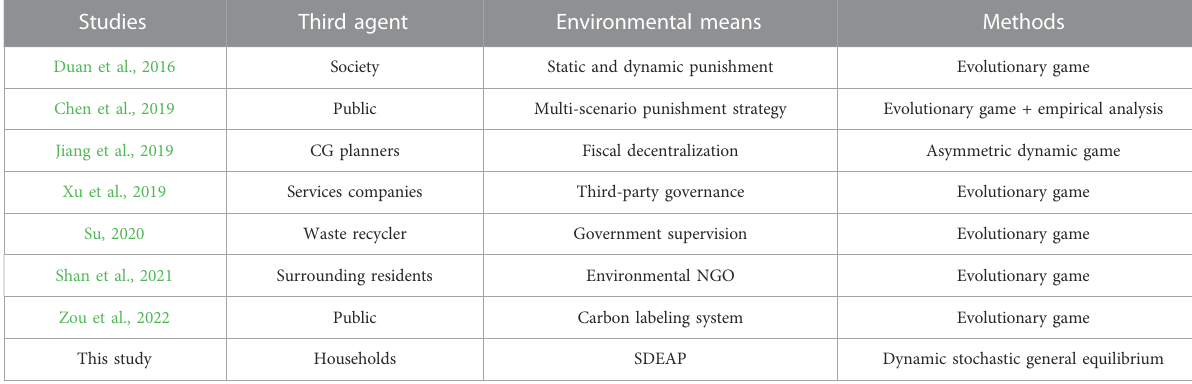
TABLE 5 Studies on the multi-agent game under environmental administrative penalty.